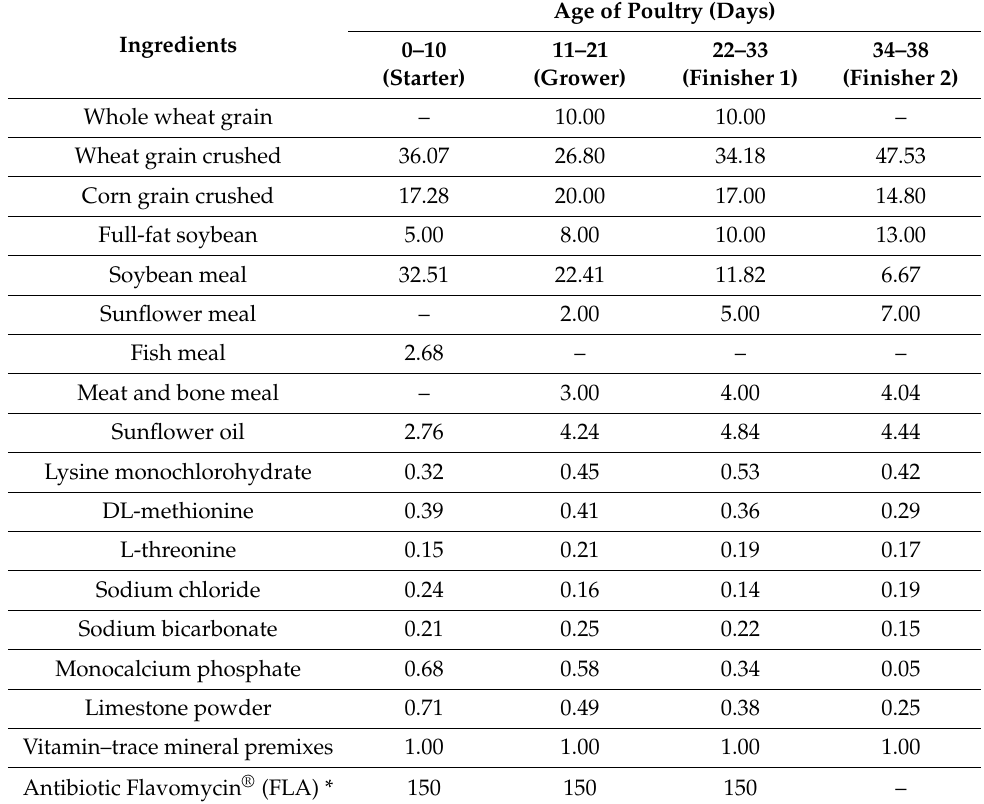
Table 2. Feed content in the rations of broiler chickens